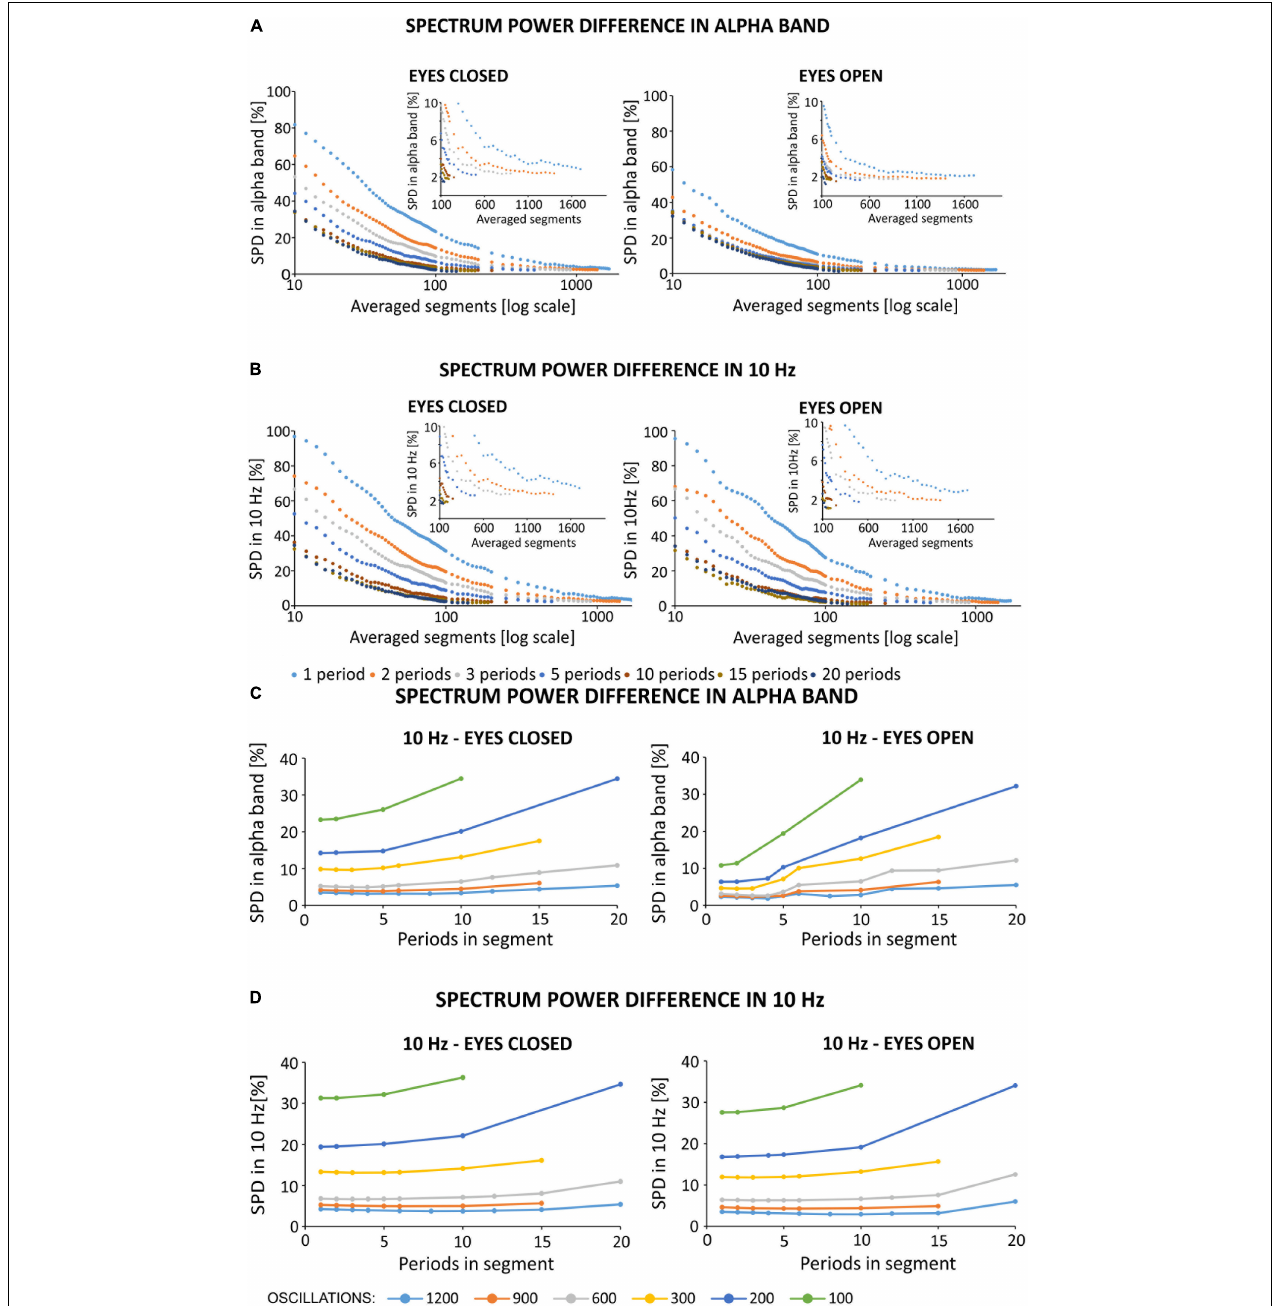
FIGURE 7 | (A,B) Spectrum percentage difference (SPD) between the original signal and the signal obtained after removing the simulated 10 Hz artifact. Simulated artifact was removed using different averaged segments that varied by the number of periods per segment. The zoomed-in portion of each chart highlights a limitation in the available number of averaged segments in different conditions (e.g., varying number of periods in each segment), and highlights the plateau phase. Due to the observed plateau phase, SPD values were determined for a range of 10–100 averaged segments in increments of 2, and in the range of 100–2000 in increments of 50. The original signal was obtained from the O2 electrode from the first participant, and downsampled to 500 Hz. (A) Results of SPD in the alpha band after simulated filtration prepared on block sh2 (i.e., eyes closed) and sh5 (i.e., eyes open). SPD in the alpha band was counted in the range of 8–12 Hz. (B) Results of SPD in 10 Hz after the simulated filtration prepared on block sh2 (i.e., eyes closed) and sh5 (i.e., eyes open). SPD in 10 Hz counted in the range of 9.5–10.5 Hz. (C,D) Spectrum percentage difference (SPD) between the original signal and the resulting signal after the removal of simulated 10 Hz artifact. Simulated artifact was removed using different averaged segments that varied by the number of periods per segment. The original signal was obtained from the O2 electrode from the first participant and was downsampled to 500 Hz. SPD values were determined according to the relationship described in Formula (9). The artifact template was created by storing the selected fixed number of oscillations to create an artifact template (i.e., 1200, 900, 600, ... ). Then, for a given number of periods in each segment, the appropriate number of averaged segments was selected. (C) SPD values in the alpha band (i.e., 8–12 Hz). (D) SPD values in 10 Hz (9.5–10.5 Hz).